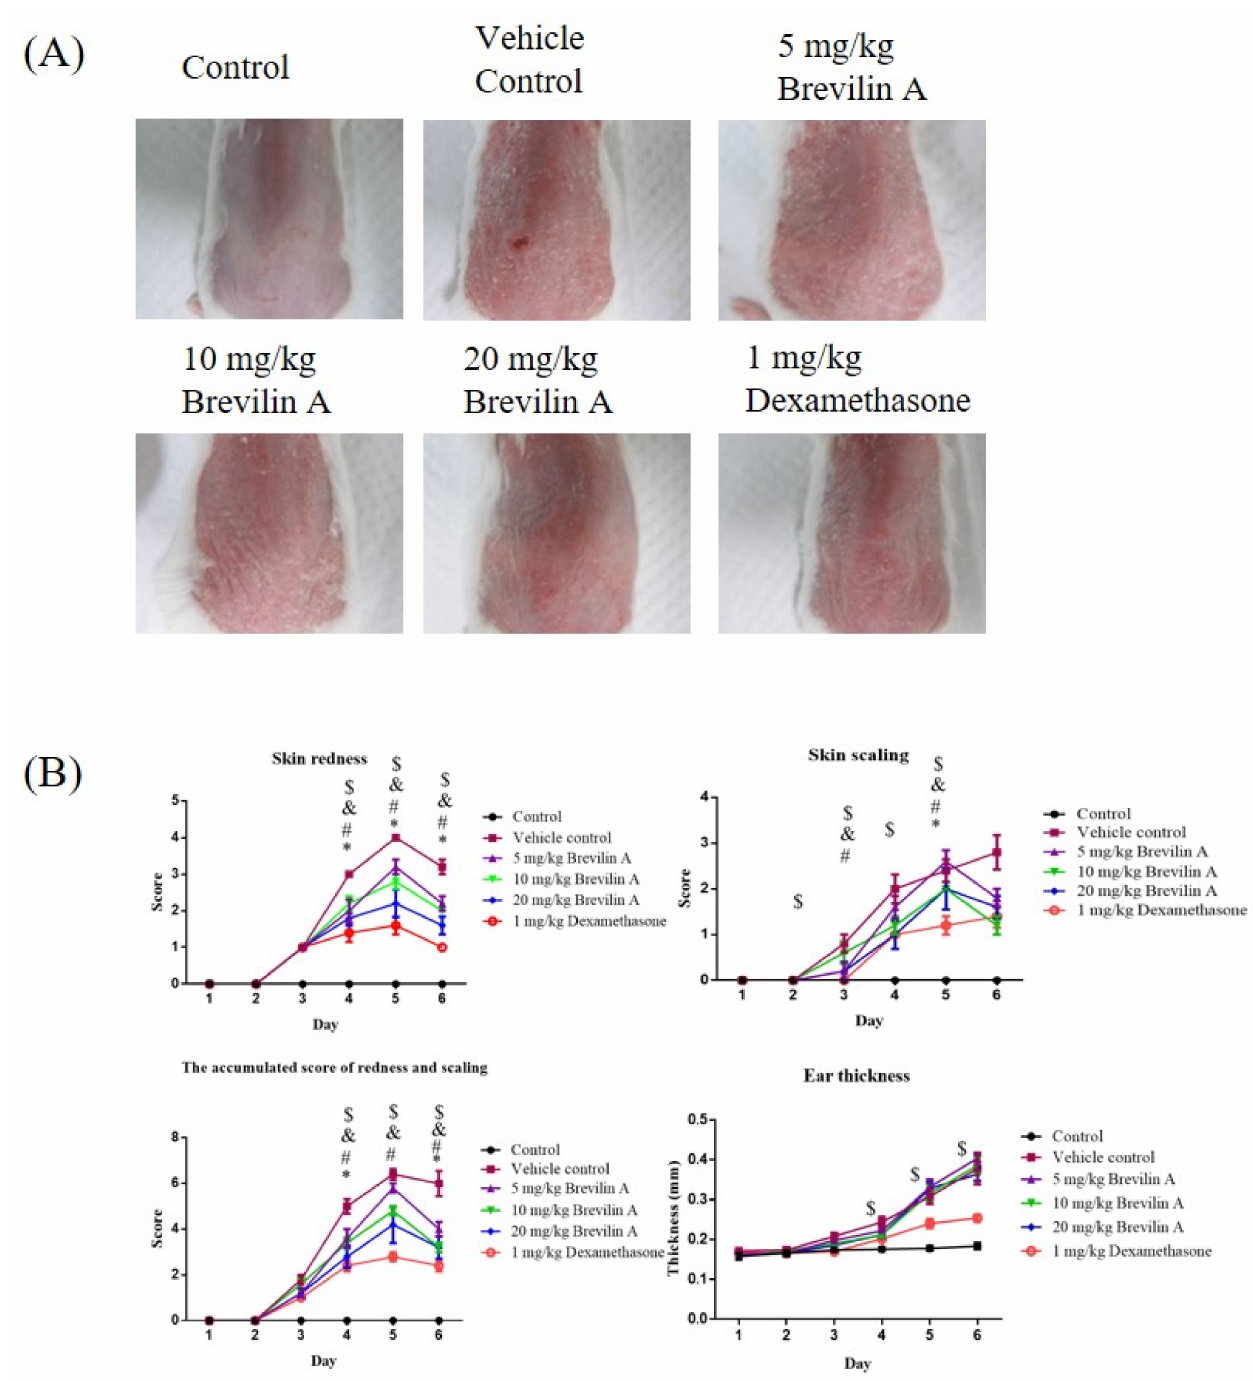
Figure 1. Brevilin A relieved skin inflammation in IMQ-induced psoriasis-like dermatitis. Except for the control group, all mice received topical application of IMQ on the shaved back for five consecutive days. In the treatment group, mice were treated with vehicle control (0.5% DMSO), brevilin A (5, 10, 20 mg/kg), and dexamethasone (1 mg/kg) on the same day that topical IMQ was applied. Mice were sacrificed on Day 6. ( A ) Psoriasis lesions of dorsal skin were present on day 6. ( B ) Skin redness and scaling were evaluated every day, and the ear thickness was measured using an electronic gauge. The accumulated scores were presented as the sum of the scores of skin redness and scaling on the back skin. Data are expressed as the mean ± SEM ( n = 5 in each group). *, #, $, & p < 0.05 vs. vehicle control group. * 5 mg/kg brevilin A; # 10 mg/kg brevilin A; & 20 mg/kg brevilin A; $ 1 mg/kg